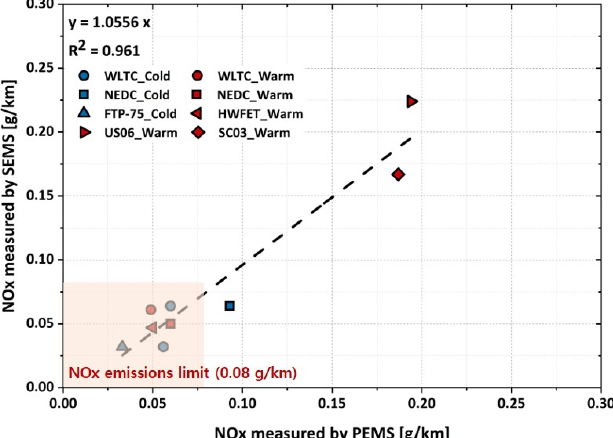
Figure 9. Correlation of NOx emissions measured by the PEMS and SEMS equipment under various test modes in the laboratory.